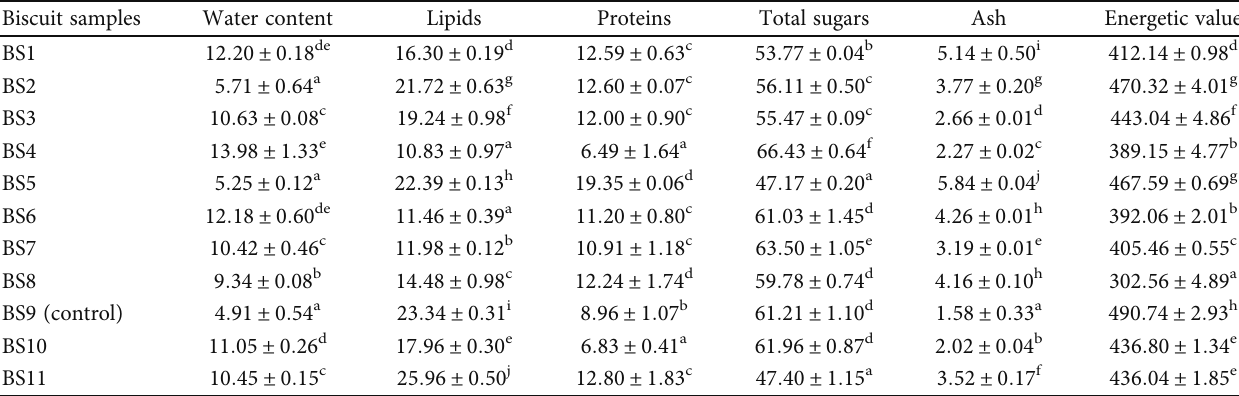
Table 3: Di ff erent formulations of biscuits: proximate composition (g/100g DM) and energetic values (kcal/100 g DM). Biscuit samples Water content Lipids Proteins Total sugars Ash Energetic